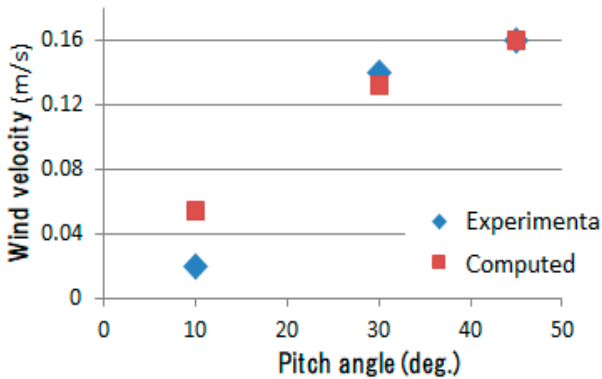
Figure 11. Velocity of generated wind in OPV-solar chimney at light intensity of 655 W/m 2 as a function of pitch angle.